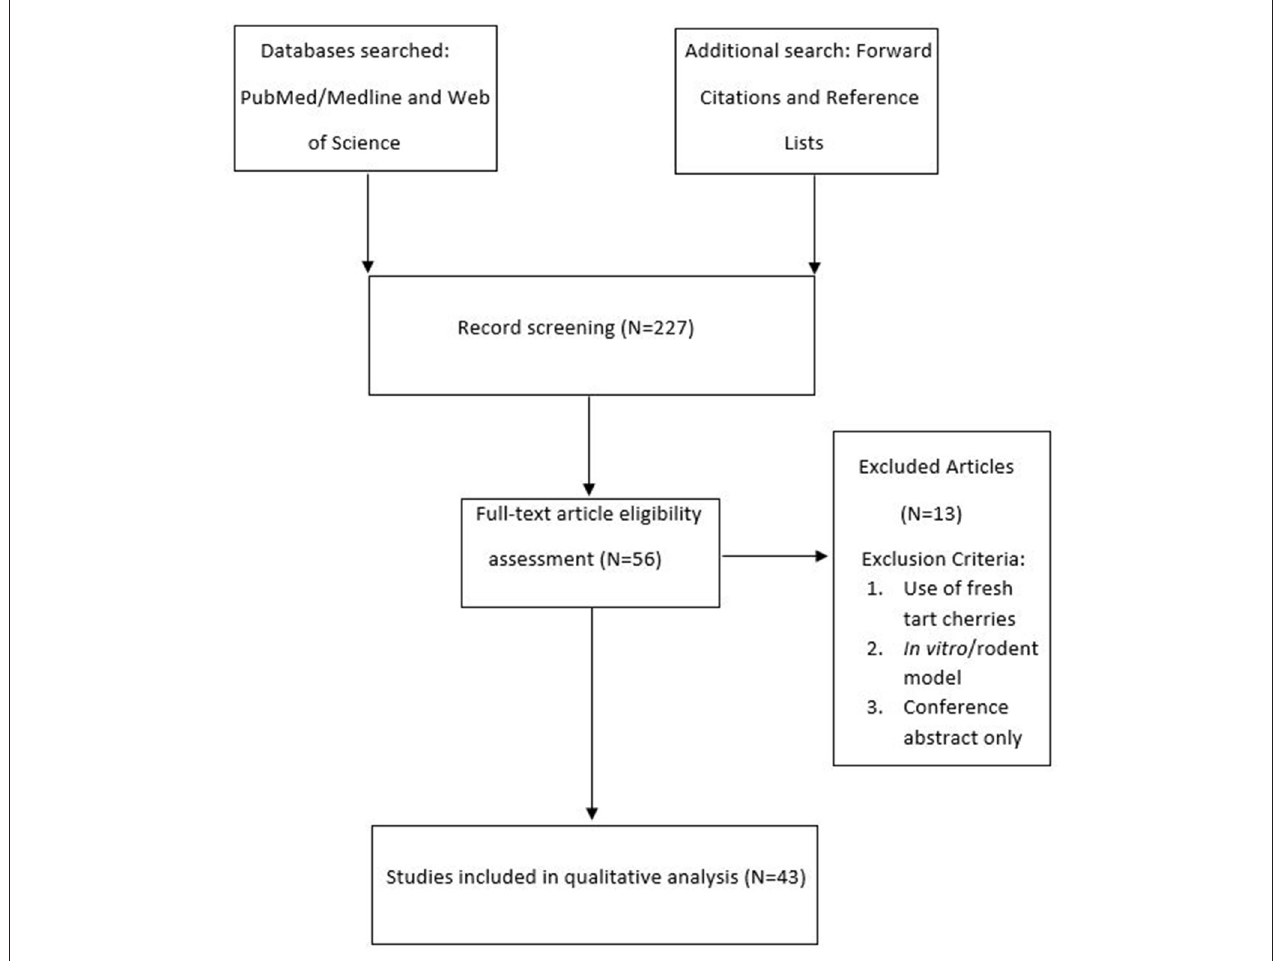
FIGURE 1 | Diagram illustrating the literature search. The number in brackets indicates the total number of studies